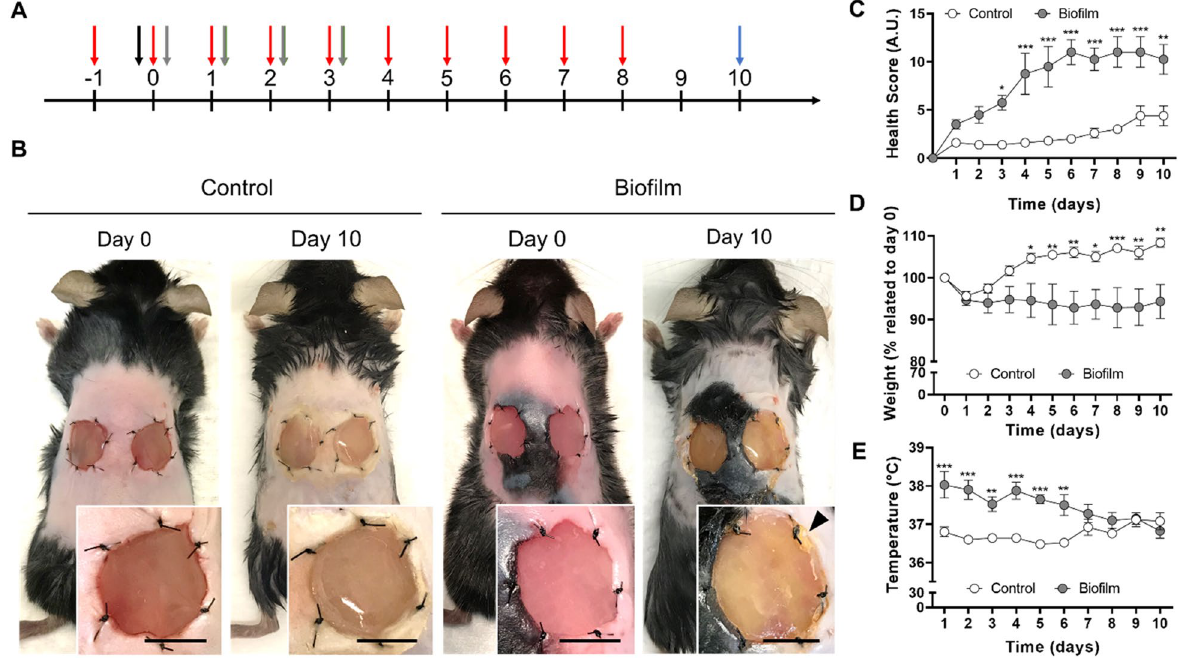
Figure 5. Time course of mice welfare during 10 days of biofilm implantation. ( A ) Timeline of the in vivo model, showing treatments and supervision timing: ciprofloxacin IP 30 mg/kg (red), surgery (black), meloxicam SC 5 mg/kg (gray), euthanasia (blue). All animals were daily supervised according to ethical protocols for general health assessment. ( B ) Representative images of control or biofilm-infected wounds in the scaffold dermal regeneration model immediately after surgery (Day 0), and after 10 days of implantation (Day 10). Arrow head indicates secretion surrounding the wound area. ( C ) Health score for assessment of welfare, indicating that biofilm-infection affects animal’s health from Day 3 to Day 10. ( D ) Relative body weight (% of initial weights at day 0), shows that biofilm-infected group did not recover their weight. ( E ) Body temperature shows that biofilm-infected group suffers from initial fever but stabilizes temperature at latest days. Scale bar represents 10 mm for B. Values plotted are mean ± SD (N = 8 per group). Two-way ANOVA and Sidak’s multiple comparison test. *p < 0.05; **p < 0.01; ***p <